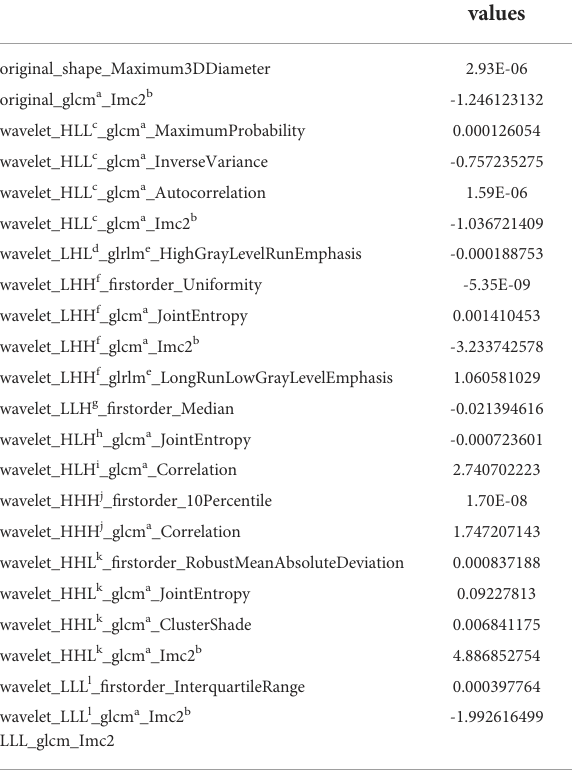
TABLE 2 Extracted radiomics features and their coef fi cients.